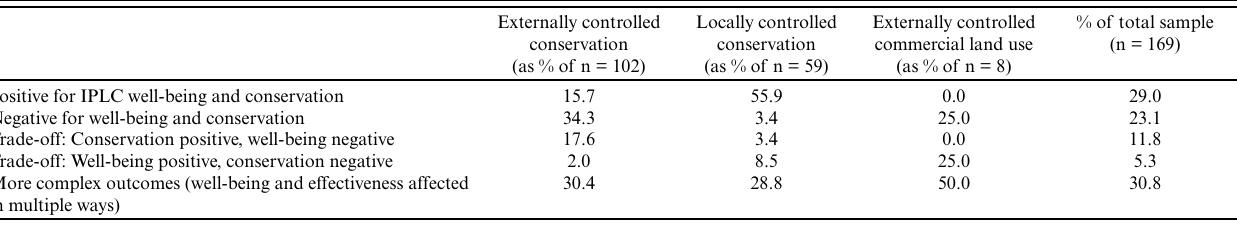
Table 1 . Combinations of social and ecological outcomes reported in 169 published studies, categorized by externally controlled versus locally controlled governance approaches. IPLC = Indigenous peoples and local communities.